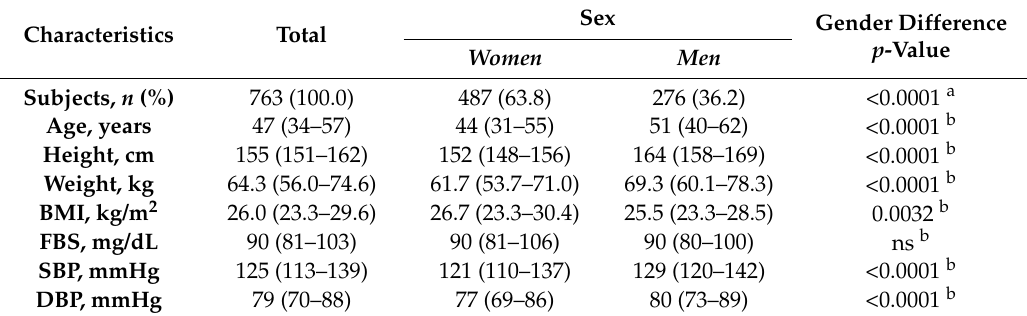
Table 1. Demographic and clinical characteristics of the Amazonian riverine population that participated in this study. Data are presented as medians and interquartile